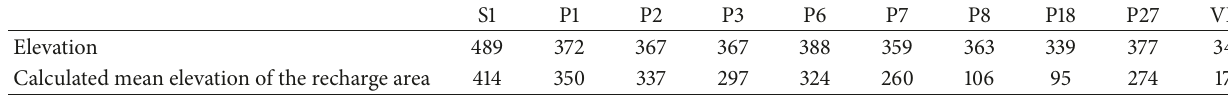
Table 3: Ground elevation of spring and wells versus mean elevation of the recharge area related to the waters collected at the same sites. The latter is calculated from the 𝛿 18 O vertical gradient experimentally obtained at the test site. All the values are expressed in masl.